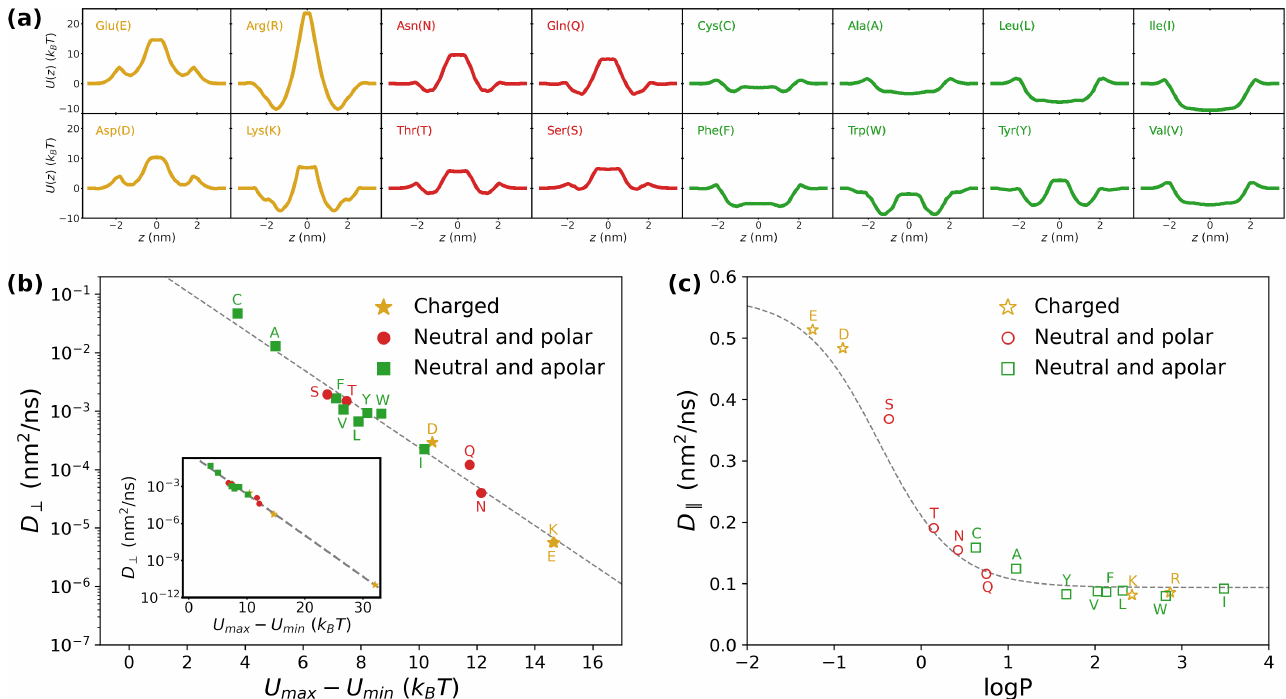
Figure 7. ( a ) Potential of mean force for 16 amino acids as computed in Ref. [63]. The plots were colour-coded according to the physico-chemical properties of the side chain: gold ↔ charged, red ↔ polar and green ↔ apolar; ( b ) perpendicular diffusion coefficient D ⊥ for charged (filled gold stars), polar (filled red circles) and apolar (filled green squares) residues as a function of the difference U max − U min between maximum and minimum height of the corresponding potential of mean force. In the inset, the full range of U max − U min is considered to include the case of Arg, for which U max − U min (cid:39) 32 k B T . The dashed grey line is a best fit via an exponential decay; ( c ) parallel diffusion coefficient D (cid:107) for charged (empty gold stars), polar (empty red circles) and apolar (empty green squares) residues as a function of the logarithm of the partition coefficient log P . The dashed grey line corresponds to the theoretical prediction according to Equation